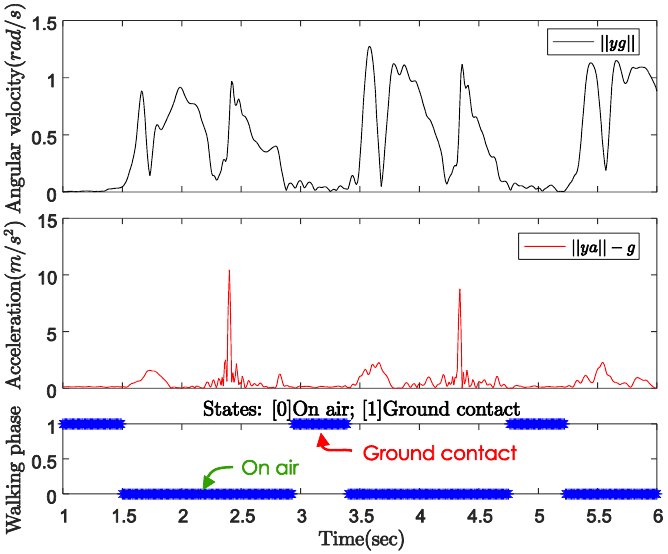
Figure 18. Quadripod cane’s output data and zero-velocity intervals.